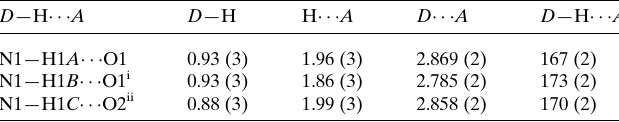
Table 5 Hydrogen-bond geometry (A˚ , (cid:5) ) for (V).